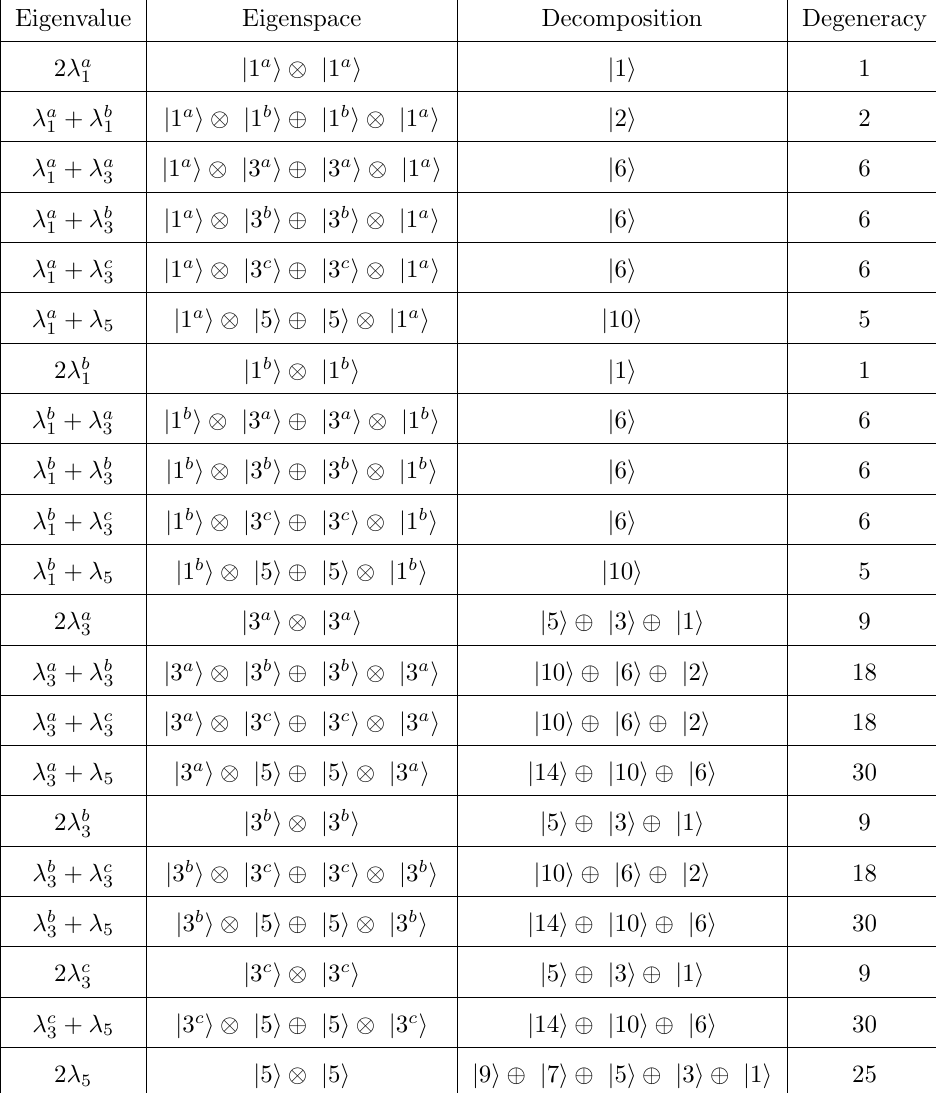
Table 6 . Spectrum of the D 2